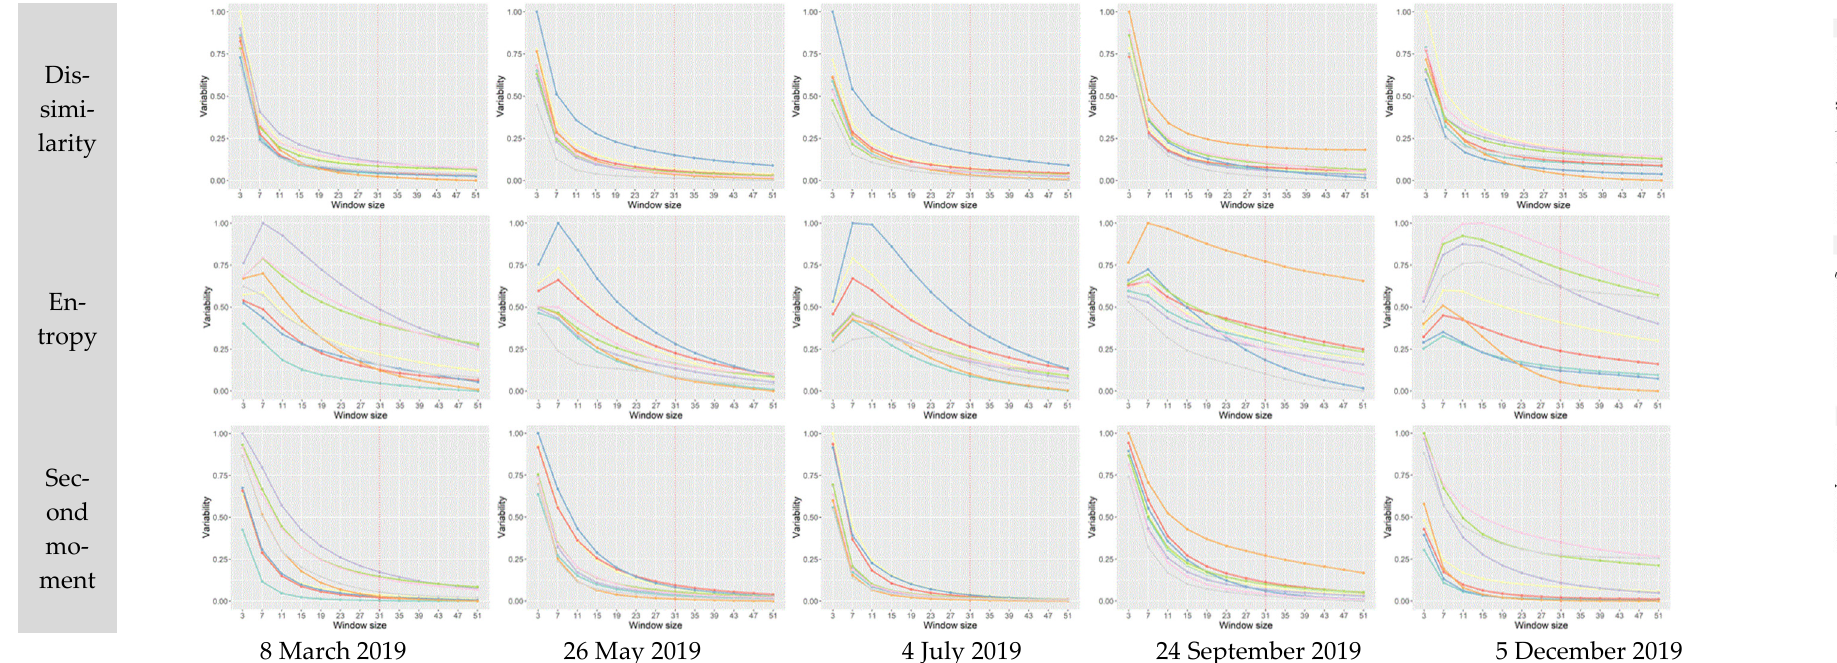
Figure 5. Variability of GLCM Statistics by Tree Species.